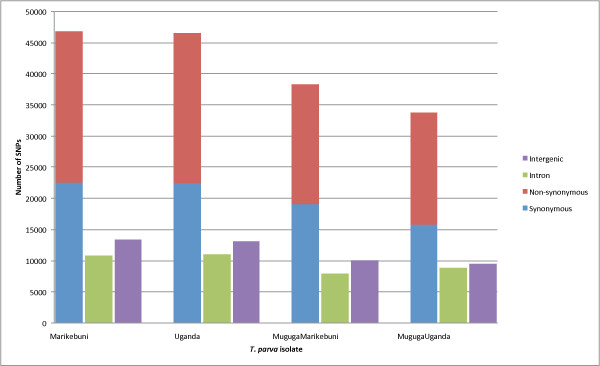
Summary of single nucleotide polymorphisms in sequenced T. parva strains.  Different coloured bars show the distribution of different SNP categories in each strain.